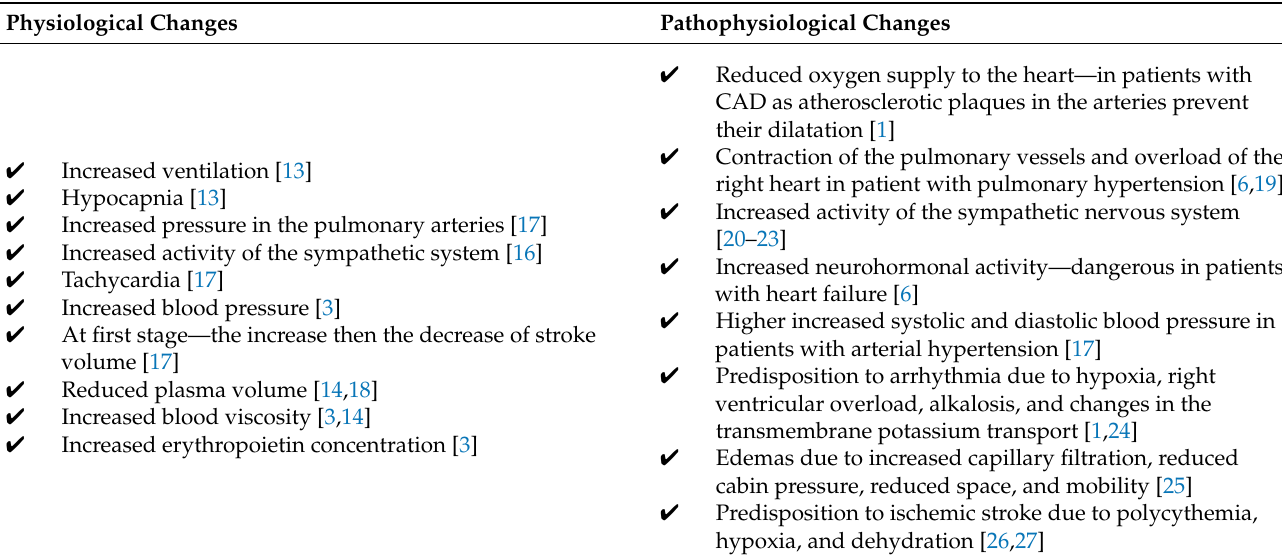
Table 1. Main physiological and pathophysiological changes in high altitude conditions. Physiological